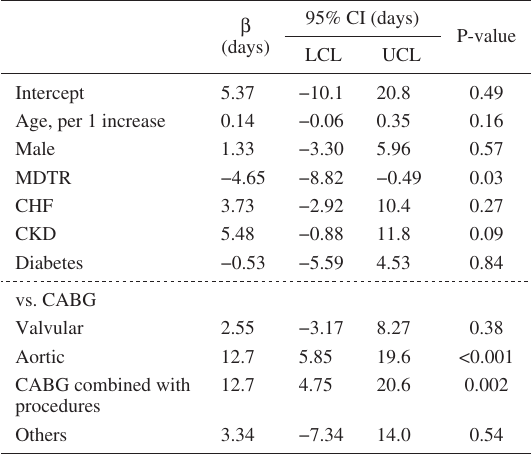
Table 3. Multiple regression analysis of postoperative hos- pital stay.